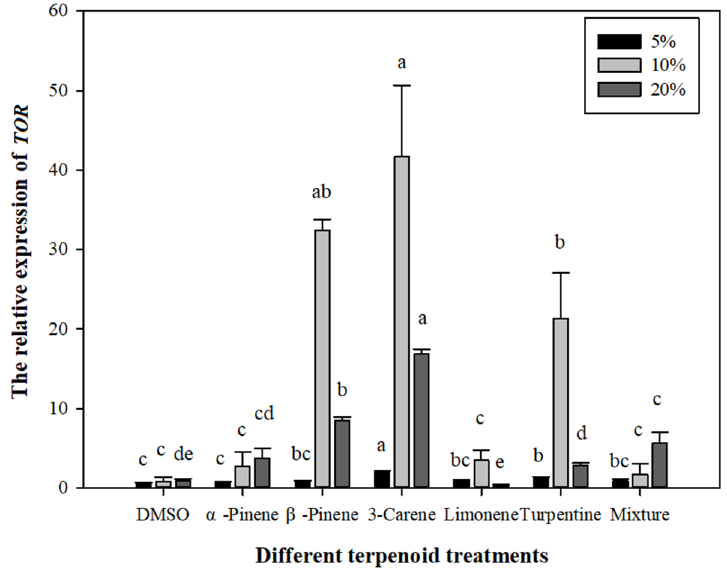
Figure 6. Effects of different terpenoid treatments on the relative expression of TOR . The relative expression of TOR is expressed as the mean ± S.E, and the different letters above the bars indicate significant differences ( p < 0.01, Tukey’s HSD test). Showing 5%, 10% and 20% concentration treatment, 7 biological replicates (DMSO as CK) and 5 technical replicates for each biological treatment.